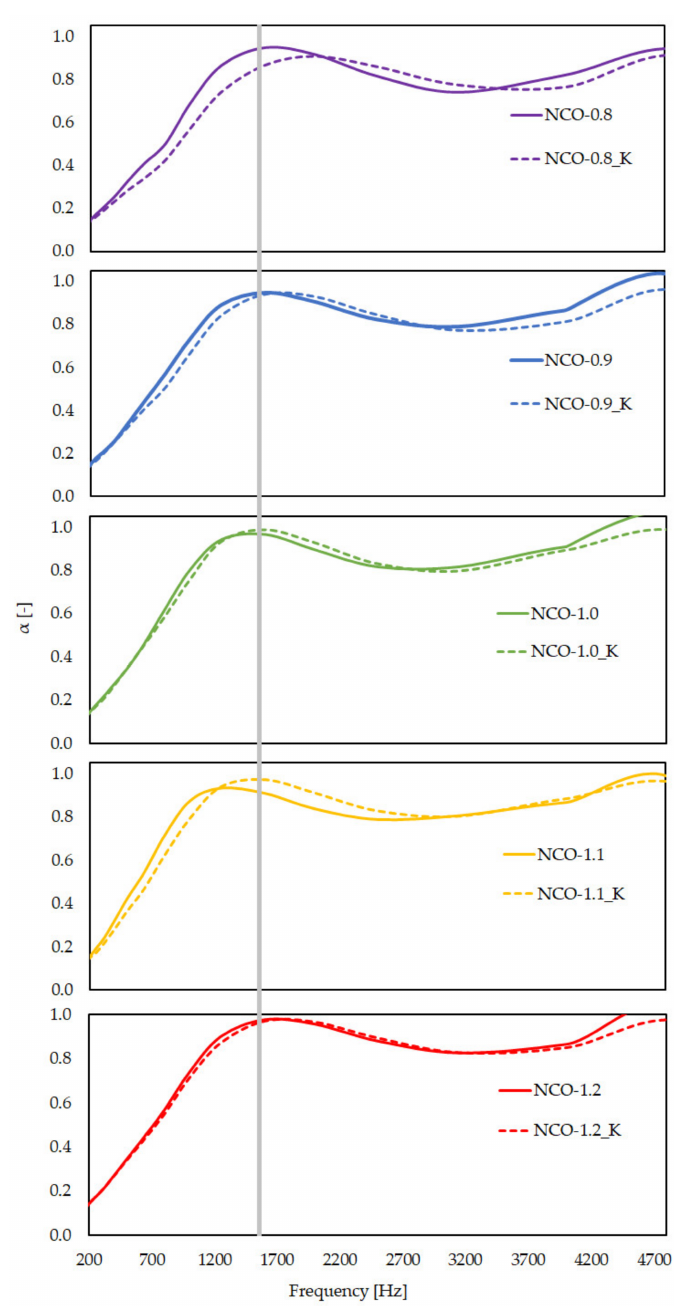
Figure 5. Average curves of the sound absorption coefficient ( α ). The samples were tested before and after aging, and the NCO index varied from 0.8 to 1.2. The average curves of the samples after dry heat aging are marked with K. The gray line marks the local maximum (~1300 Hz) from which the useful frequency range